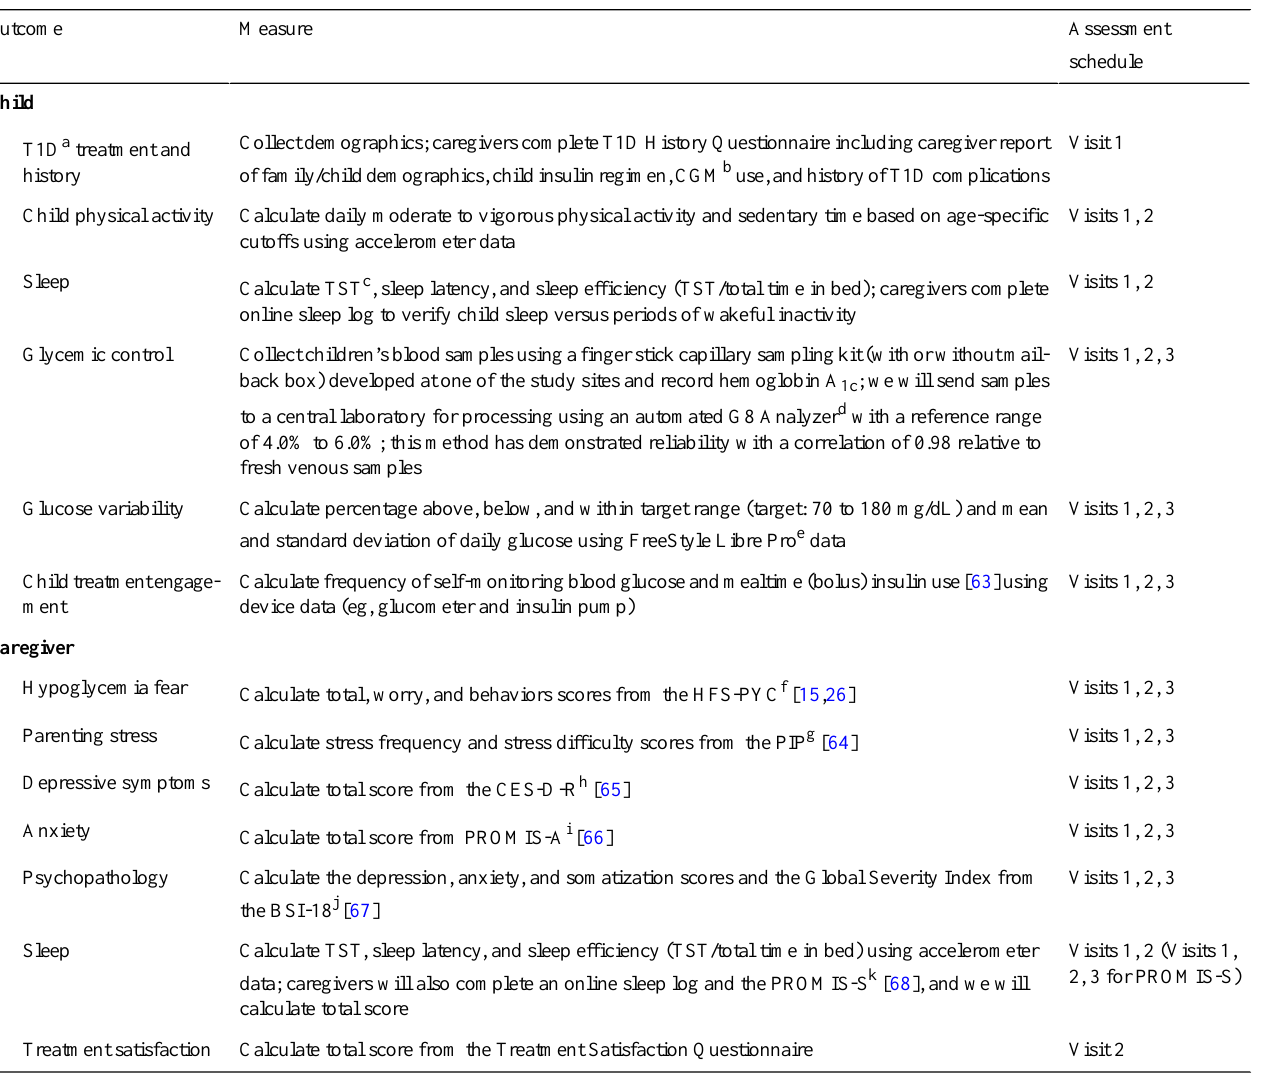
Table 3. Study outcome